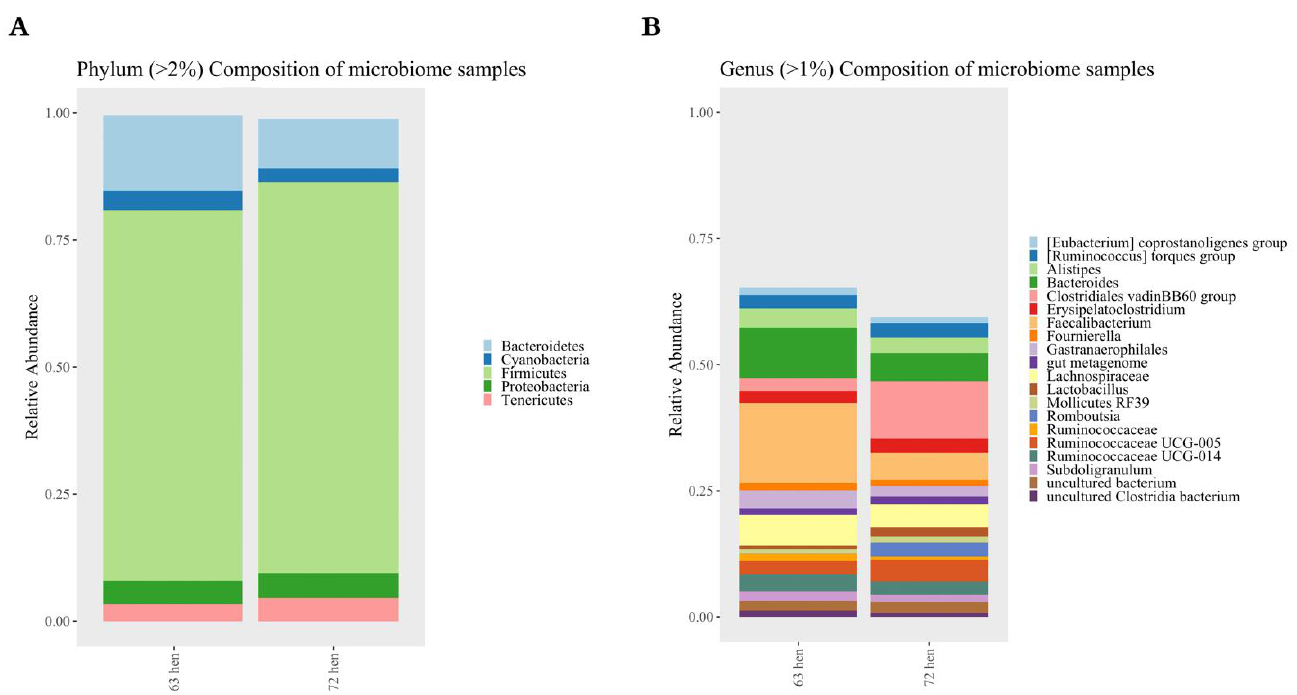
Figure 4. The different cecal bacterial compositions between two diversely selected chicken lines (n = 10). ( A ) phyla, and ( B ) genera analyses that compose an average of >2% and >1%, respectively, of the community, while other minor phyla or genera are not shown.